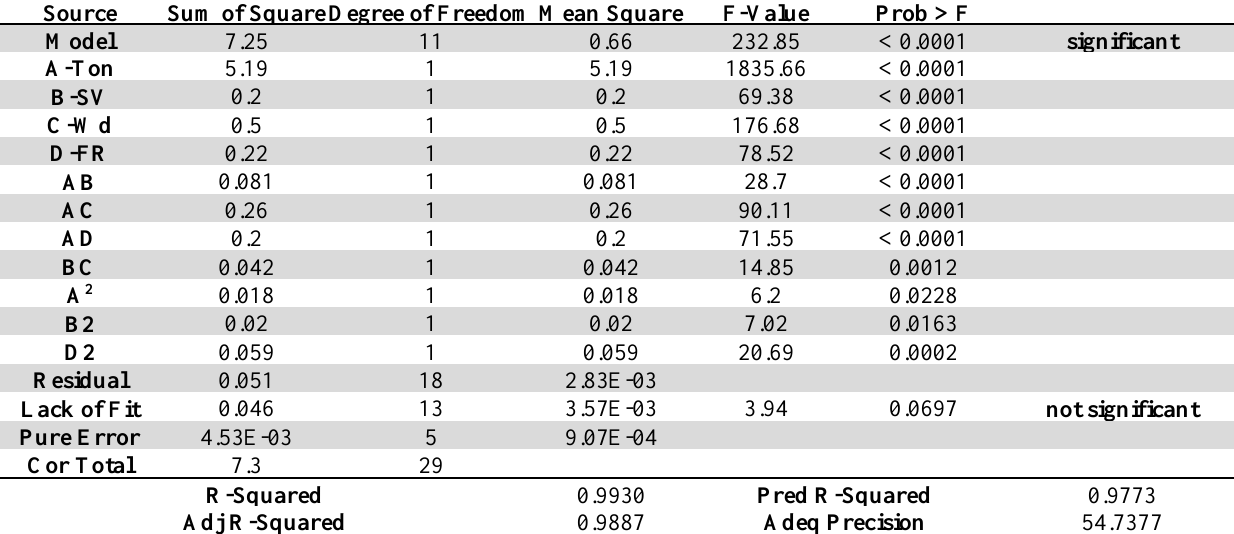
ANOVA table for fitted model for